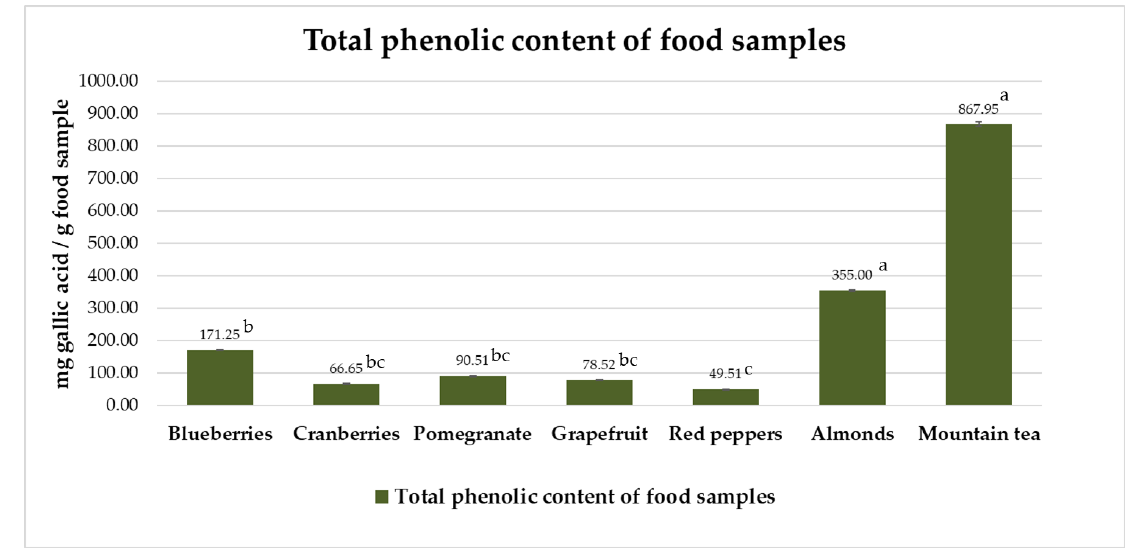
Figure 2. Mean and SD values of total phenolic content of different food samples as determined by the Folin-Ciocalteau assay. Statistically significant differences are portrayed with superscripts (different letters).